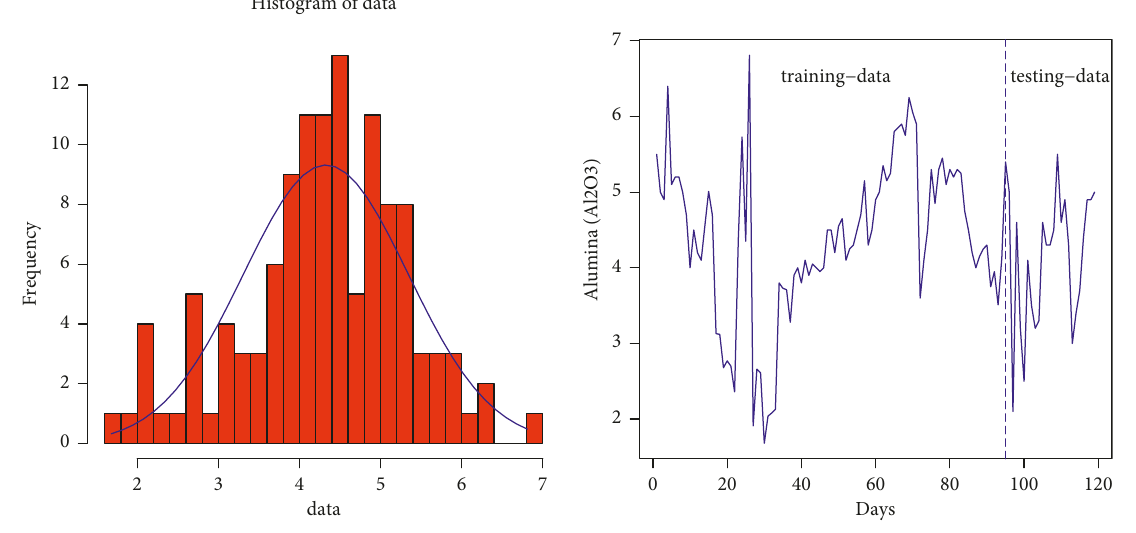
Figure 4: Histogram and line chart of Al